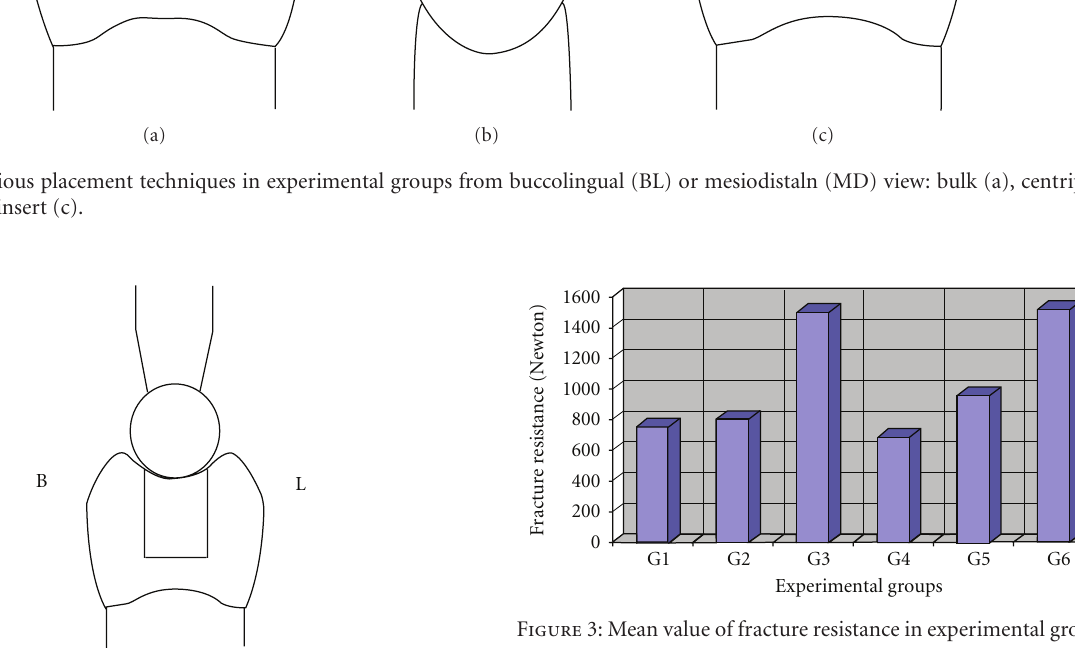
Figure 2: Schematic representation load cell on specimens in buccolingual (BL) view.